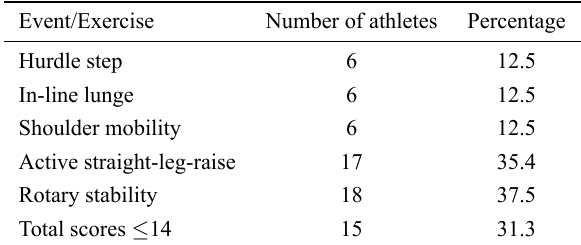
Table 2. Unbalance on both sides of the FMS test and the total score is less than 14 points (n =